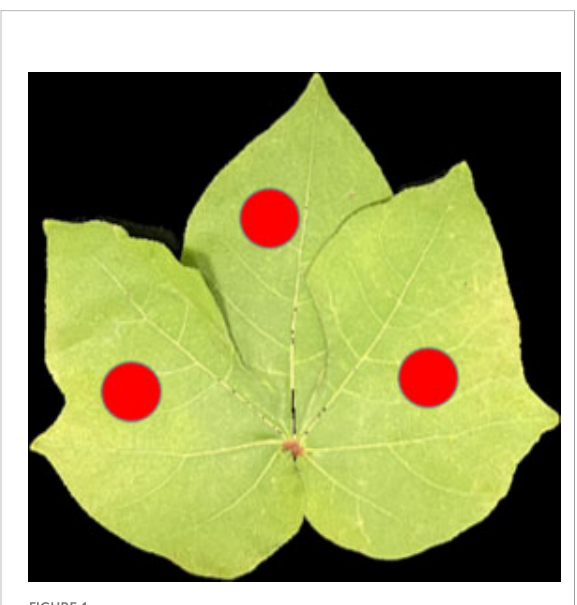
FIGURE 1 The regions of spectra acquisition for cotton